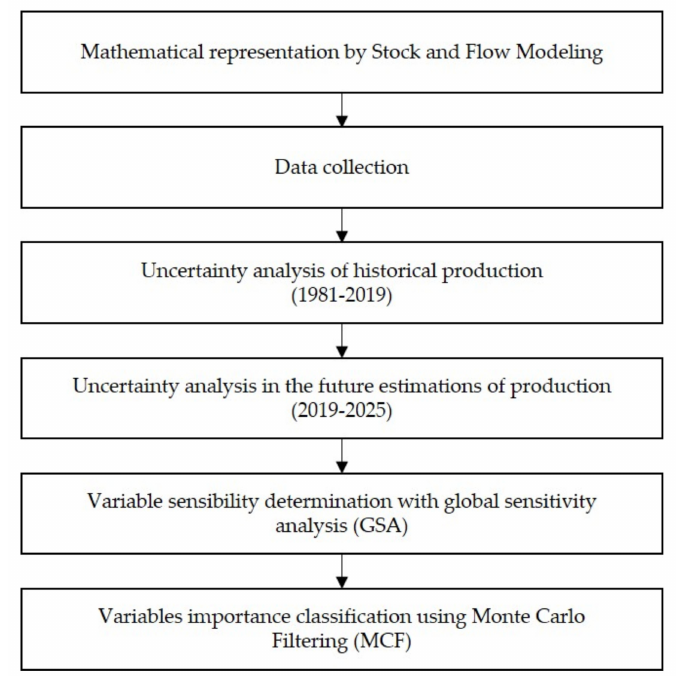
Figure 1. The methodology representing the six steps for the supply chain